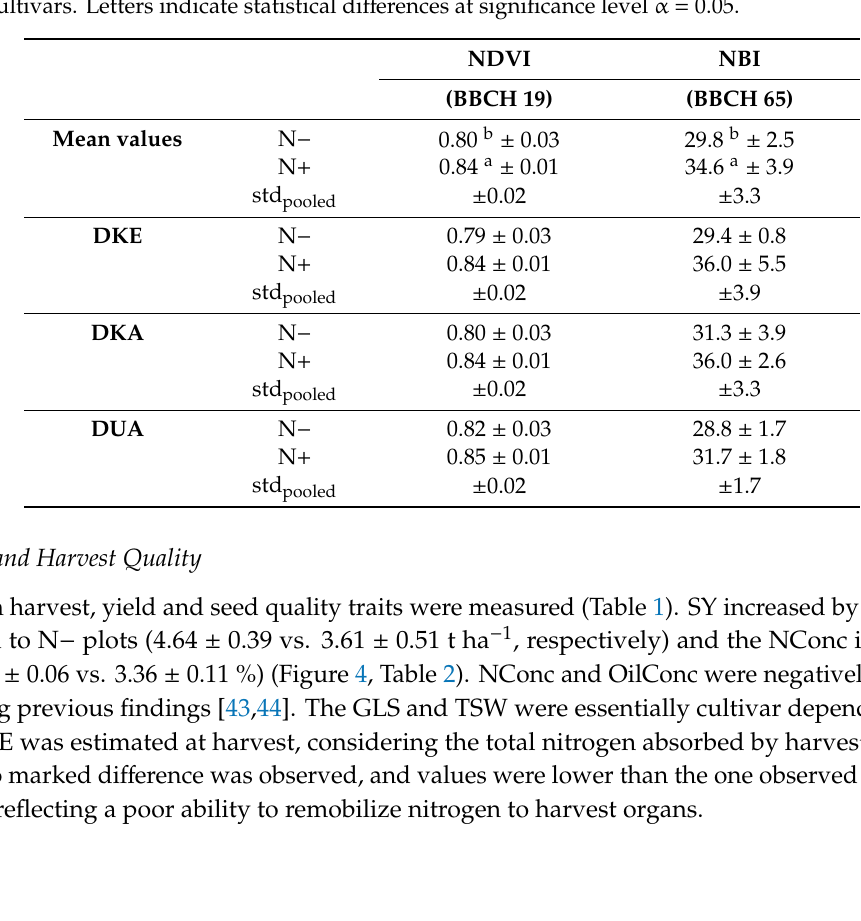
Table 3. Leaf optical parameters in response to nitrogen fertilization treatment. The Normalized Di ff erence Vegetation Index (NDVI) and the Nitrogen Balance Index (NBI) were measured on canopy of control (N − ) or fertilized (N + ) plots respectively at BBCH 19 and BBCH 65. Mean values according to the fertilizer treatments (n = 12 ± std) and to individual cultivars (n = 4 ± std). Pooled standard deviations (std pooled ) of N − and N + populations are mentioned according to the fertilizer treatment and cultivars. Letters indicate statistical di ff erences at significance level α =